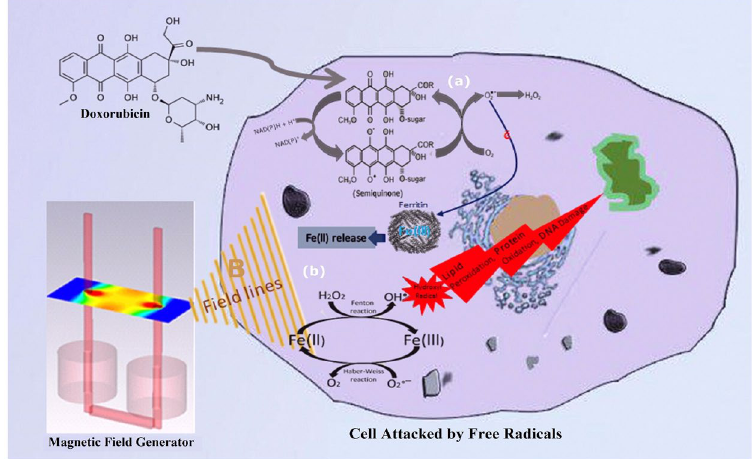
Figure 7. Schematic diagram of intracellular cross-talk in ROS generation by homogeneous magnetic field and Doxorubicin. ( a ) Doxorubicin induces Fe (II) release by direct interactions of O 2 •− with intracellular iron accumulations as ferritin, ( b ) in parallel magnetic field amplifies formation of ROS through Fenton reaction, which lead to DNA damage, protein oxidation and lipid